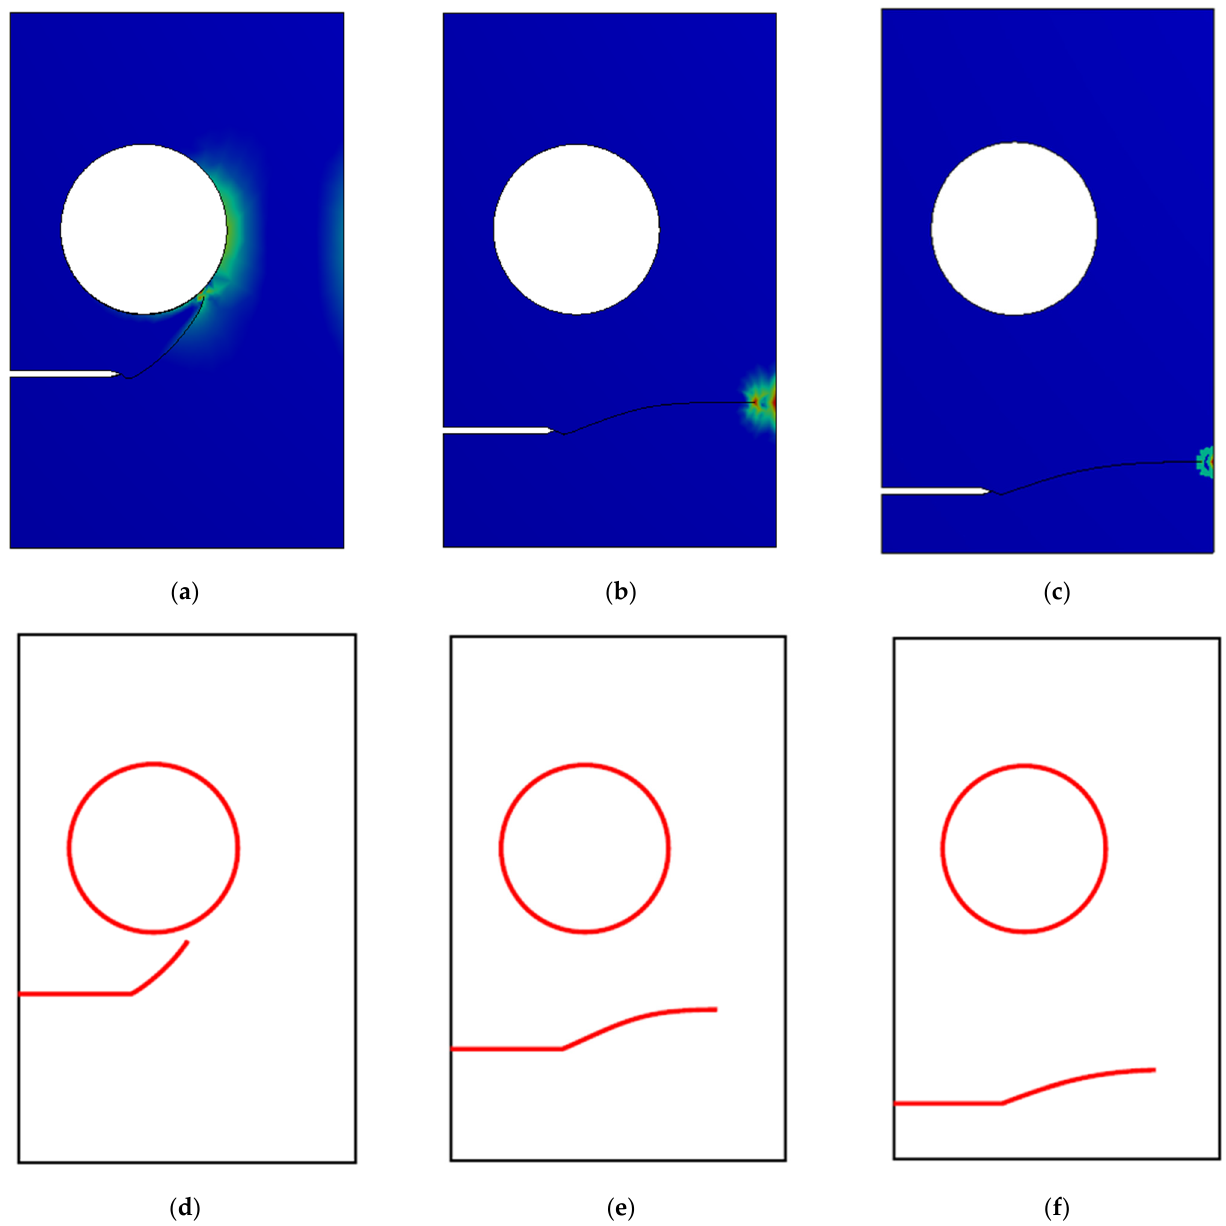
Figure 19. Comparison for the crack growth path, ( a ) h = 15 (present study), ( b ) h = 10 (present study), ( c ) h = 5 (present study), ( d ) h = 15 [52], ( e ) h = 10 [52], ( f ) h = 5. Copyright permission obtained from Elsevier [52].